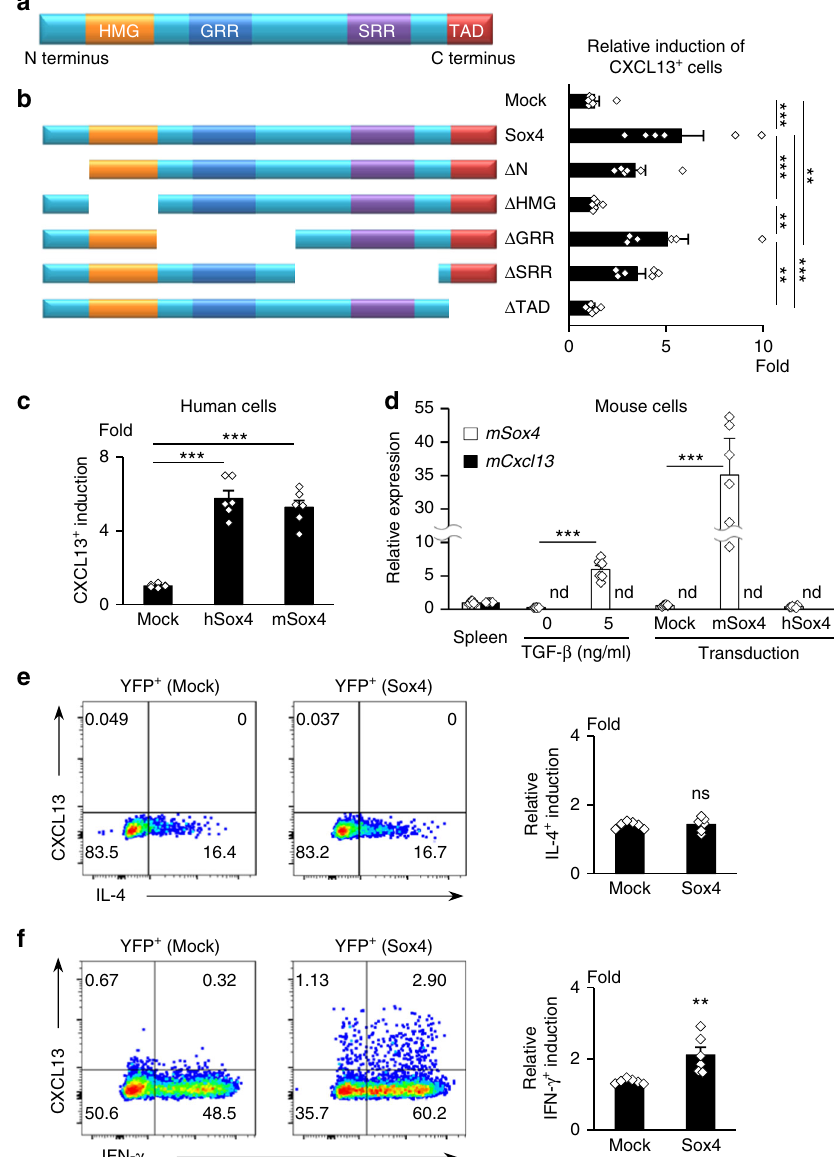
Fig. 4 Conserved domains HMG and TAD are functionally crucial for CXCL13 induction in human CD4 + T cells. a Structure of Sox4 protein. b Wild - type Sox4 or Sox4 truncated at the indicated domain (left) were transduced into human naive CD4 + T cells, followed by differentiation for 5 days. Relative induction of CXCL13-positive cells in YFP + cells compared with YFP − cells is shown (right). c Relative CXCL13 induction in differentiated human naive CD4 + T cells transduced with human and mouse Sox4. d Relative expression of mSox4 and mCxcl13 in mouse spleen tissue (de fi ned as 1.0), in mouse CD4 + T cells cultured for 5 days with TCR stimulation and TGF- β , and in Sox4-transduced mouse CD4 + T cells differentiated for 5 days. e , f Mock- or Sox4- transduced human naive CD4 + T cells were differentiated under Th2-polarizing ( e ) or Th1-polarizing ( f ) conditions. Representative dot plots of YFP + gated cells and relative IL-4 ( e ) or IFN- γ ( f ) induction in YFP + cells compared with YFP − cells are shown. Cumulative data ( n = 6) are presented as corresponding dots and the mean ± SEM. ** P < 0.01 and *** P < 0.001 by one-way ANOVA, Tukey ’ s test in b and c , and by unpaired t -test in d , e , and f ; nd, not detectable; ns, not signi fi formation of ELSs and the Sox4 expression in areas with or that in fl ammatory conditions regulate the expression of Sox4, without ELSs in RA synovium. Interestingly, ELS formation and MAF, and TOX, and that the ELS formation regulated by Sox4 expression in RA synovium were signi fi cantly correlated CXCL13 expression depends on upregulated Sox4 expression in (Fig. 5g). To further investigate the expression of Sox4 and human CD4 + T cells. CXCL13 in T cells in fi ltrating the RA synovium, we performed triple immunostainings of RA synovium with anti-CD3, Sox4, Sox4 expression correlates with ELS formation in RA syno- and CXCL13 antibodies. Consistent with the in vitro and in vivo vium . Finally, we investigated the expression and distribution of fi ndings reported above, T cells in fi ltrating the RA synovium Sox4 in RA synovium. Sox4 expression was localized in cells preferentially expressed Sox4 and CXCL13 (Fig. 5h and Supple- in fi ltrating the sublining layer of RA synovium (Fig. 5f and mentary Fig. 10). Considering that PD-1 hi CXCR5 − CD4 + T cells Supplementary Fig. 9). We semi-quantitatively evaluated the